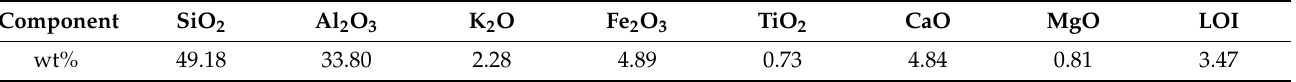
Table 1. Chemical composition of fly